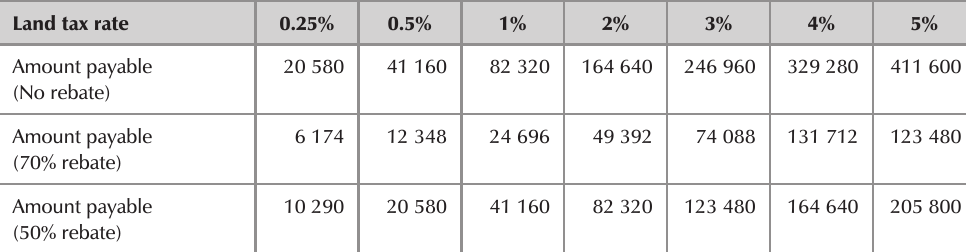
Annual land tax payable with and without a rebate: Intensive poultry farm (egg